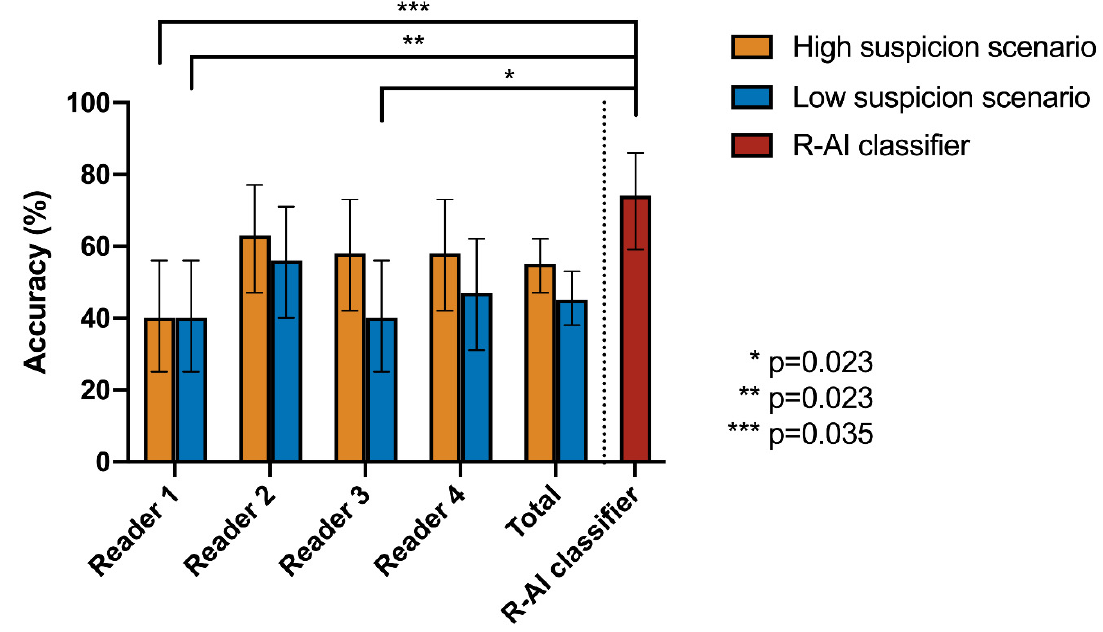
Figure 4. Comparison between the performance of the radiomic-based artificial intelligence (R-AI) classifier and the four readers in differentiating COVID-19 from other types of viral pneumonia in the subset ( n = 43) of patients who were assigned a CO-RADS 3 score by two or more. Bars on graph boxes represent the 95% confidence interval of the accuracy values. Significant results of pairwise McNemar test after Bonferroni’s correction were reported.